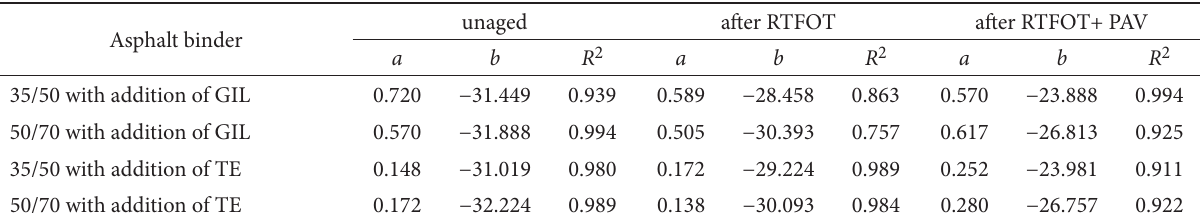
Table 8. The values of the average critical temperature determined by tests in the BBR and calculated for asphalt binders modified by adding Gilsonite